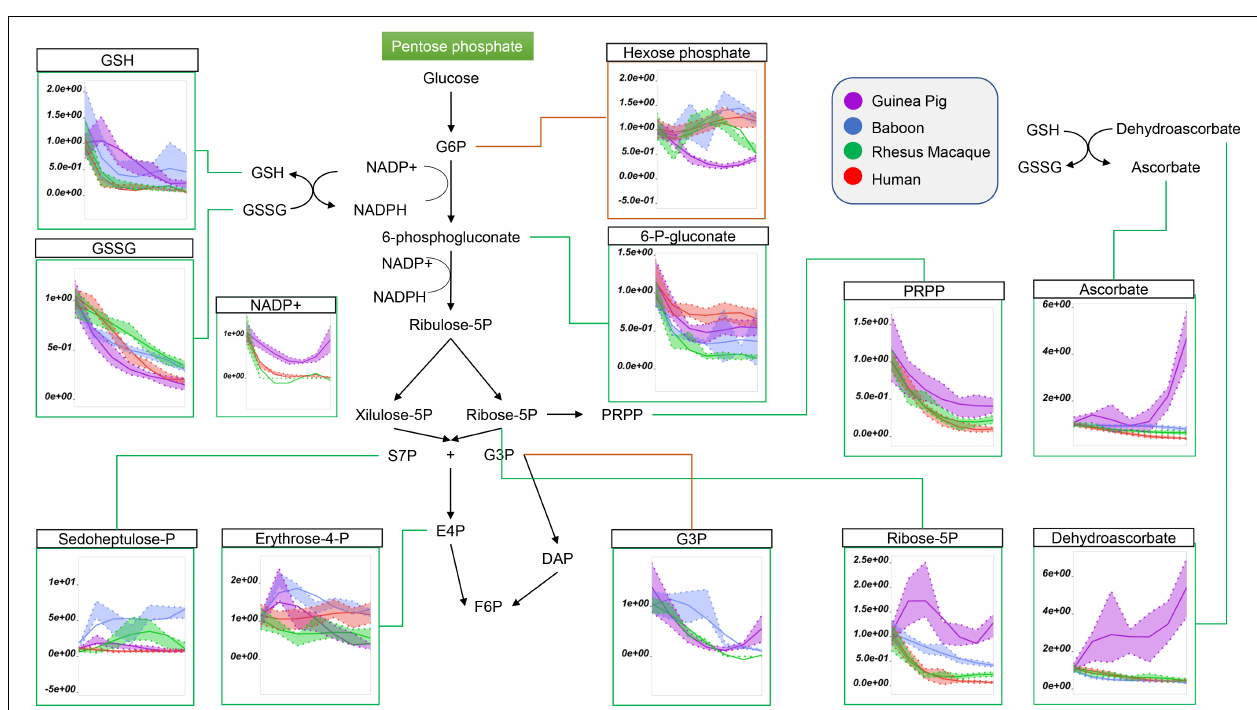
FIGURE 2 | Impact of storage on glycolytic metabolites and high-energy purines (ATP, ADP, AMP) in stored RBCs from guinea pigs (violet), baboons (blue), rhesus macaques (green), and humans (red). Line plots indicate metabolite medians (lighter colored areas are ranges) normalized to measurements in fresh, non-stored blood (day 0) and autoscale normalized across groups. All metabolites are significant by ANOVA (FDR corrected– p < 0.05).